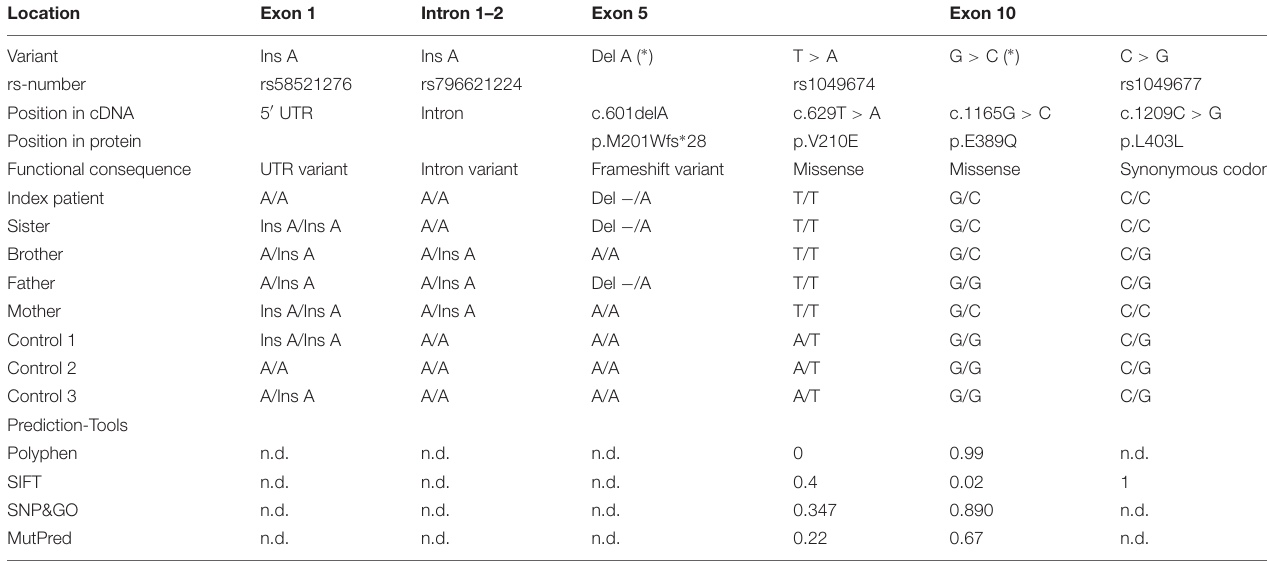
TABLE 2 | Sequencing result in cases and